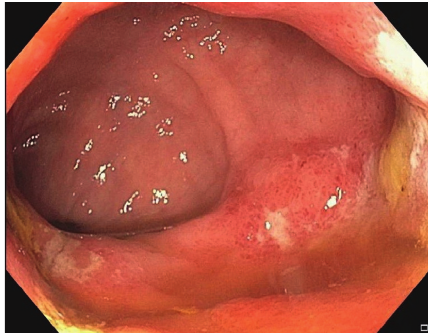
Figure 1: Colonoscopy showing rectum with proctitis, charac- terized by erythema and scattered superficial ulcerations.